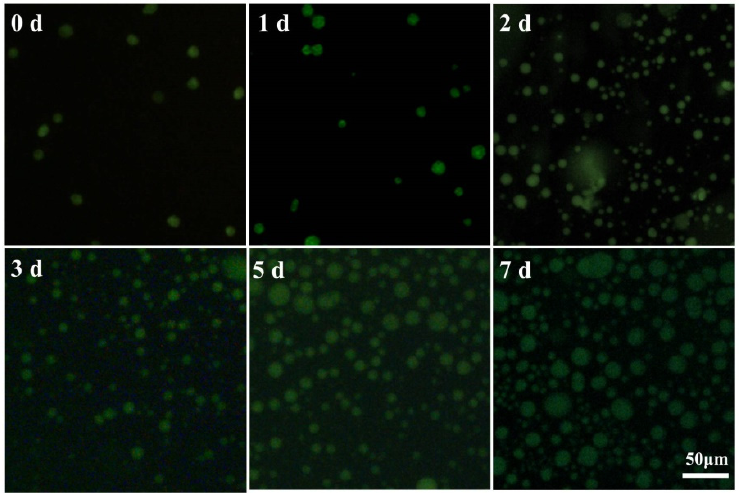
Figure 7. Fluorescence images of MCF-7 cells cultured in the formed thermosensitive P(OEGMA- co-MEO 2 MA) hydrogel. The cells were stained with acridine orange (AO) and ethidium bromide (EB) beforehand.